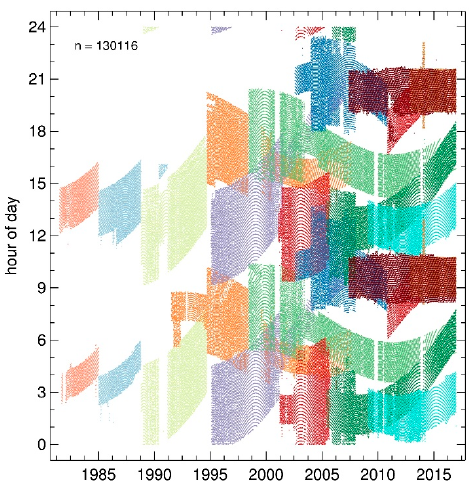
Figure 4. Overpass times of all AVHRR scenes in which Lake Geneva is visible. Each dot represents a scene; the different colors represents different platforms.